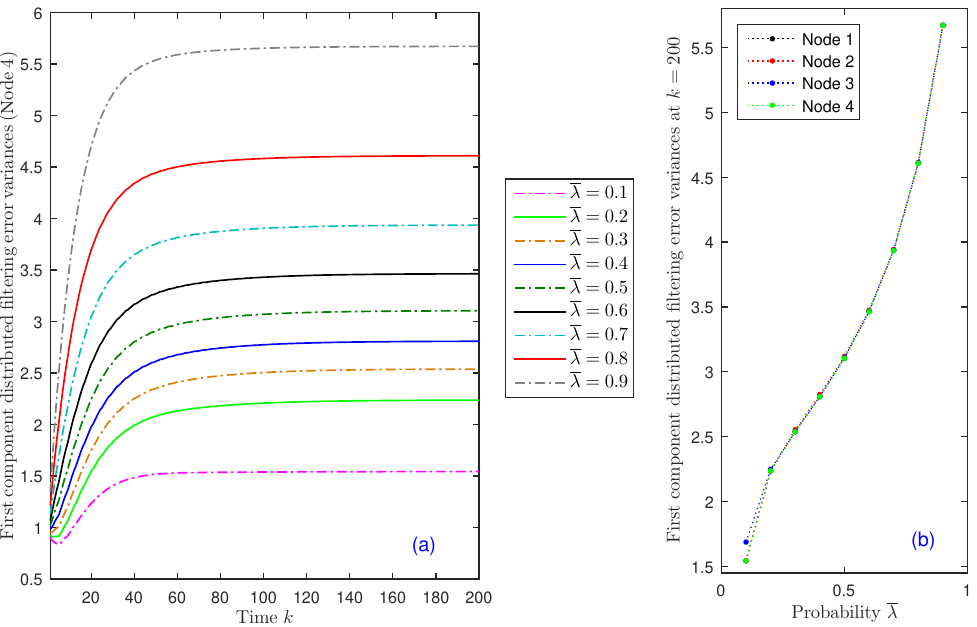
Figure 4. Distributed filtering error variances: ( a ) for λ = 0.1 to 0.9, in Node 4; ( b ) at k = 200, versus λ , in all